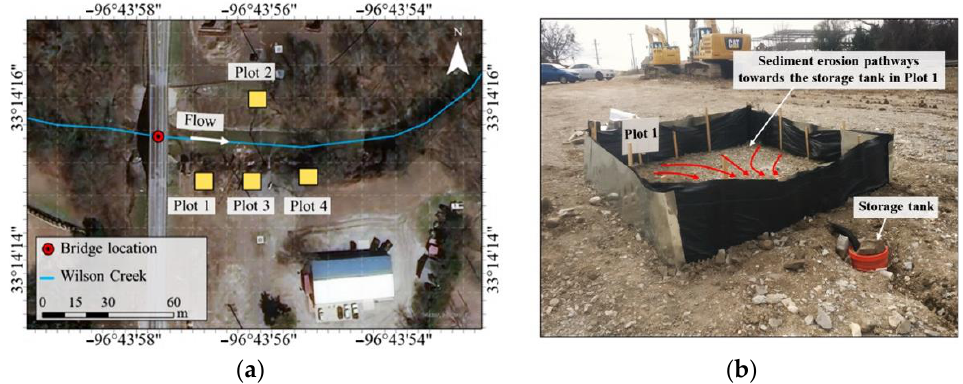
Figure 8. ( a ) Location of erosion plots on the north and south sides of Wilson Creek downstream of the bridge location, and ( b ) Erosion plot No.1 and its components. the bridge location, and ( b ) Erosion plot No.1 and its components.